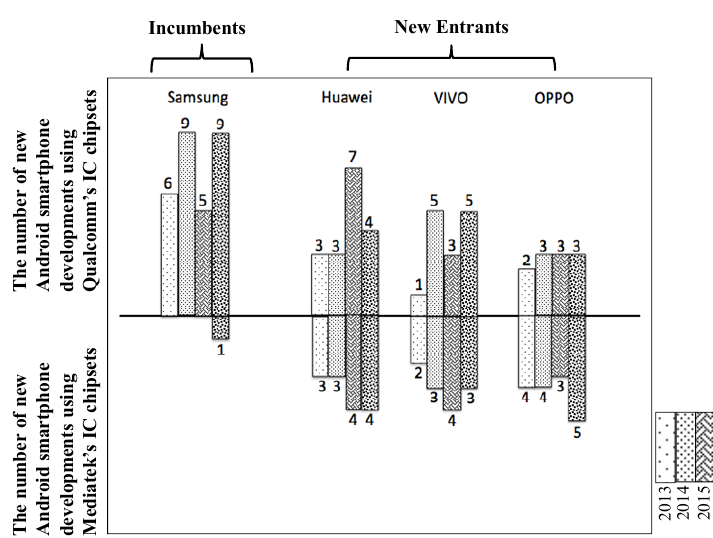
Figure 1. The number of IC chipsets adopted in Samsung’s, Huawei’s, Vivo’s and OPPO’s Android smartphone